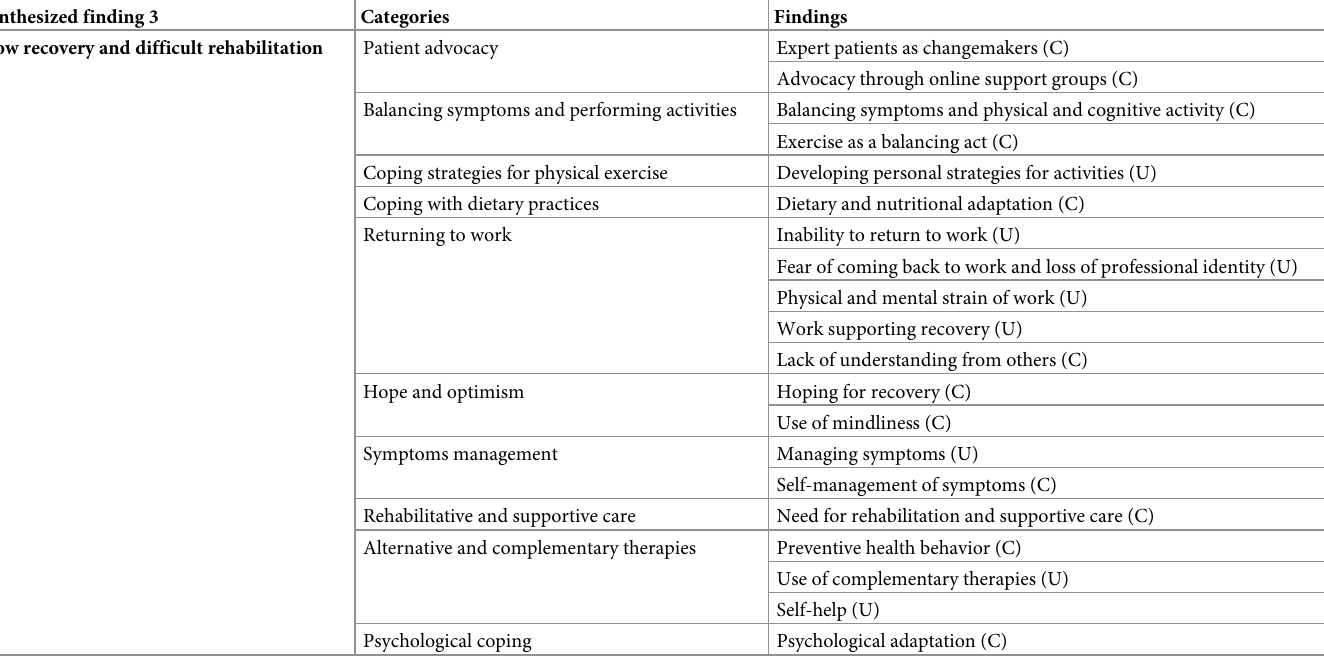
Table 5. Findings and categories within synthesized finding 3. Synthesized finding